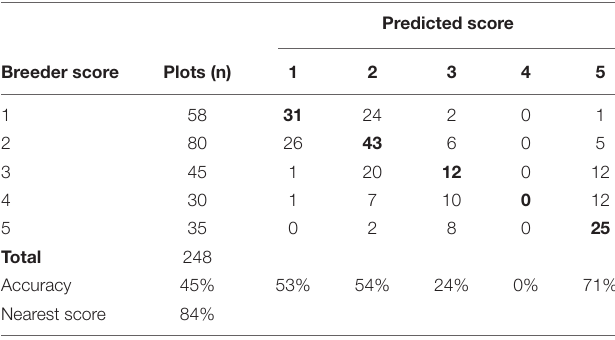
The bold figures represent the visual scores which were correctly classified by logistic models. TABLE 9 | Confusion matrix of LLS visual scores of the breeder scores and predicted scores of data collected at NaSARRI 2020B.